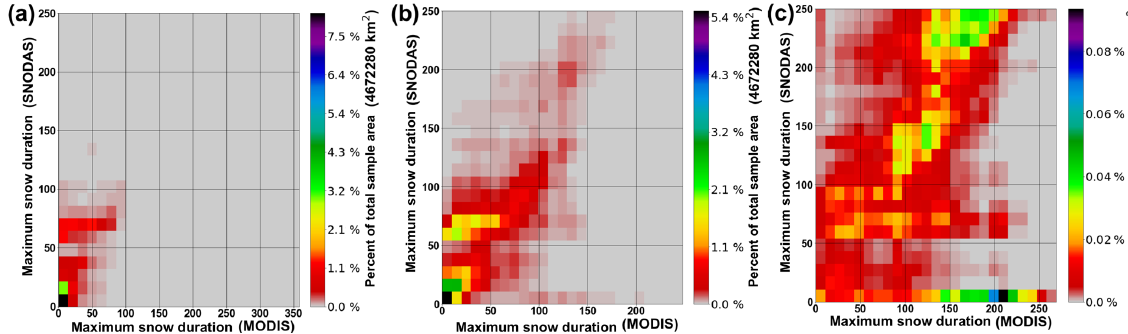
Figure 6. Maximum consecutive snow duration (maximum snow duration) measured using MODIS and Snow Data Assimilation System